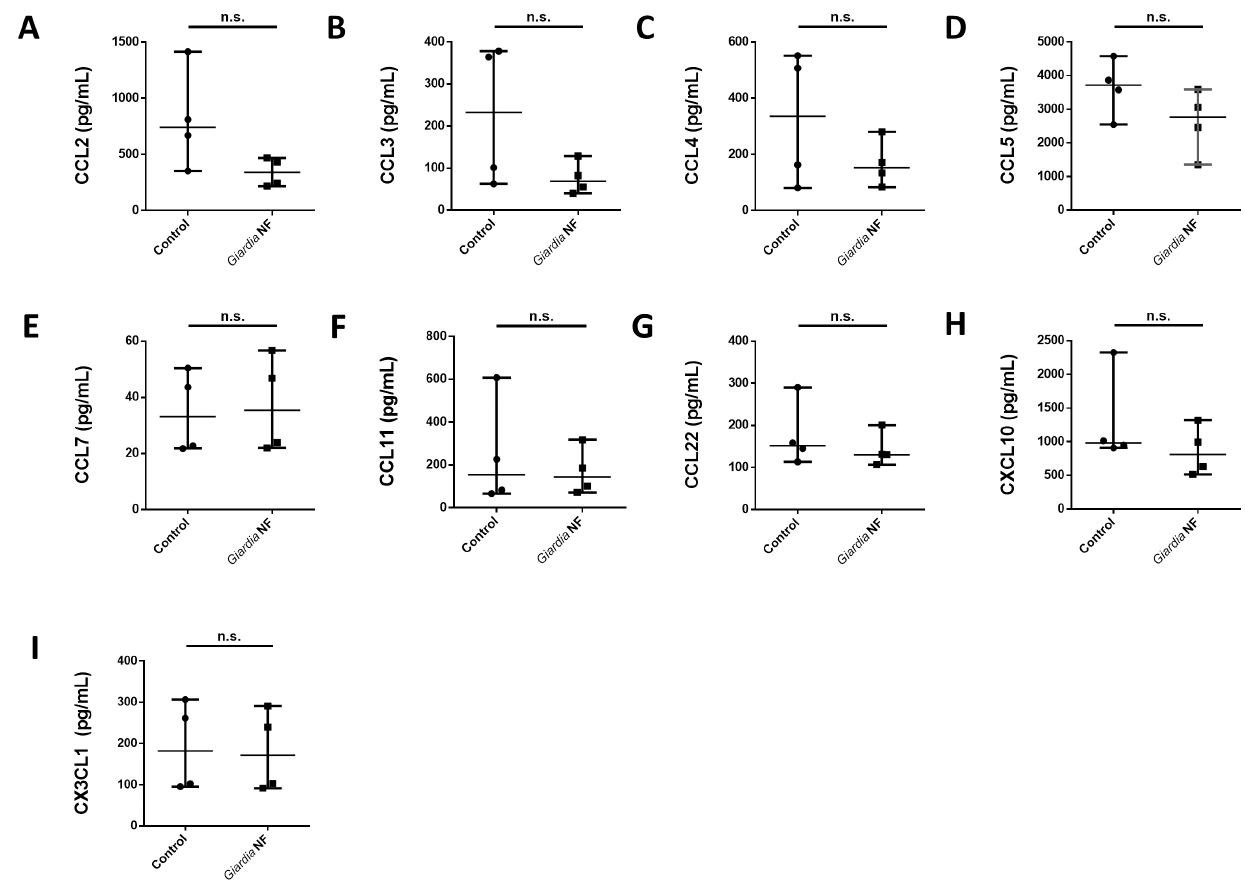
Figure 9. Giardia NF trophozoites do not attenuate the expression of several chemokines assessed in colonic mucosal biopsy tissue homogenates. Human descending colon mucosal biopsy tissues obtained from areas of active inflammation from patients with active Crohn’s disease (CD) were incubated with 5.0 6 10 6 Giardia NF trophozoites for 6 hours. Tissue homogenate levels of (A) CCL2, (B) CCL4, (C) CCL5, (D) CCL7, (E) CCL11, (F) CCL22, (G) CXCL10, and (H) CX 3 CL1 were determined via a bead-based cytokine assay. All data are representative of three independent experiments (n=4–6/group) and represented as median with the range. * p , 0.05.